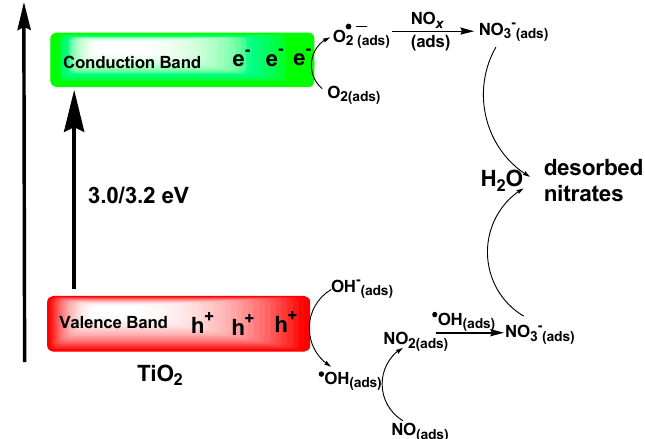
Figure 22. Suggested mechanism for the photocatalyzed oxidative removal of NO x over the irradiated surface of the two TiO 2 photocatalytic substrates.